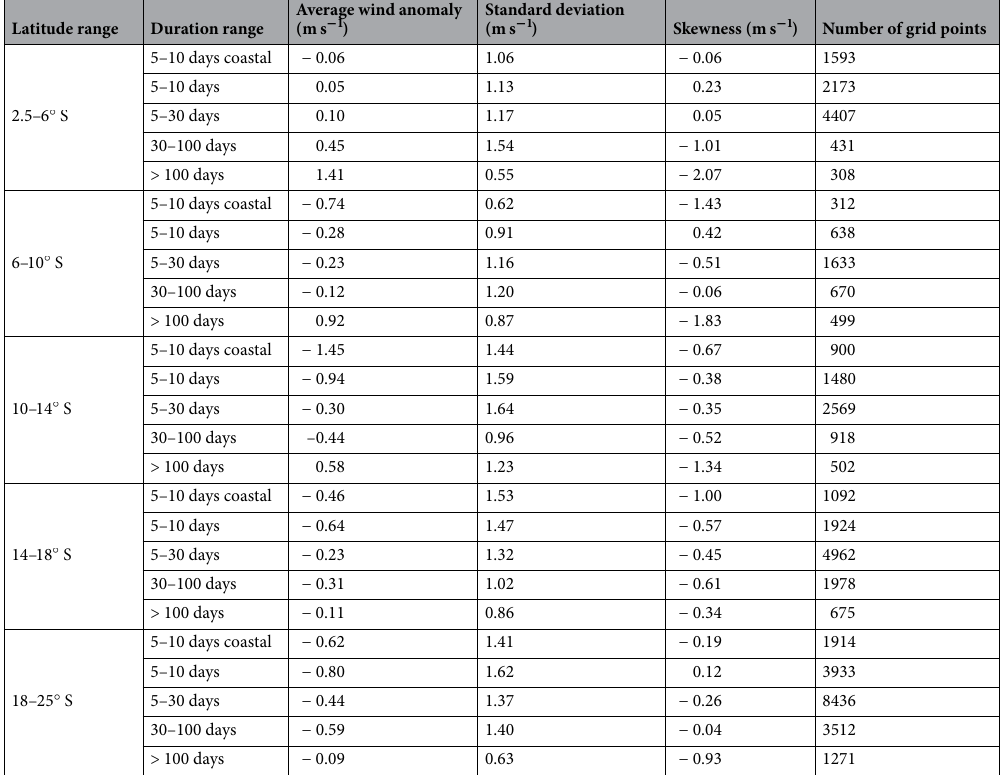
Table 2. Statistics derived from the wind anomaly observed on the first day of a MHW. Statistics are shown in 5 coastal sub-domains and for different MHW duration. The category “5–10 days coastal” regroups MHWs that are located less than 100 km from the coast, the other categories are within 2.5 column indicates the number of grid point over which the average is